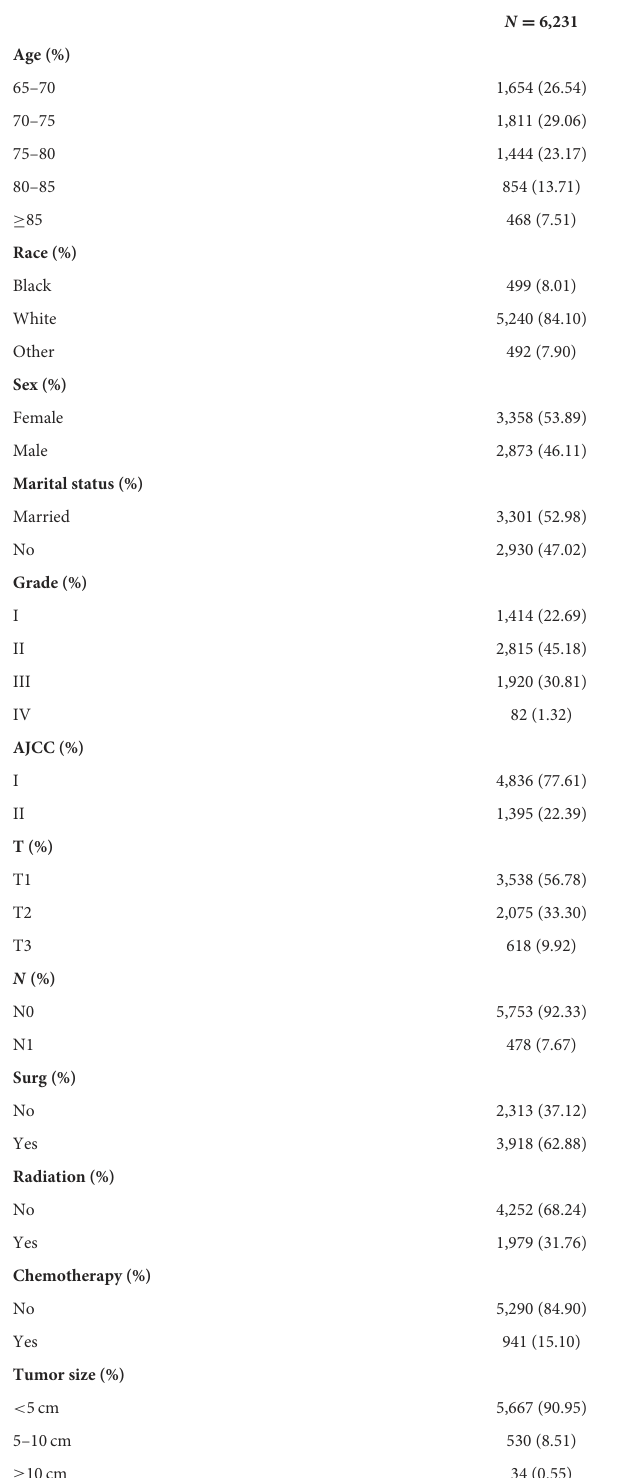
TABLE 2 Clinicopathological characteristics of elderly lung cancer patients——the external validation.